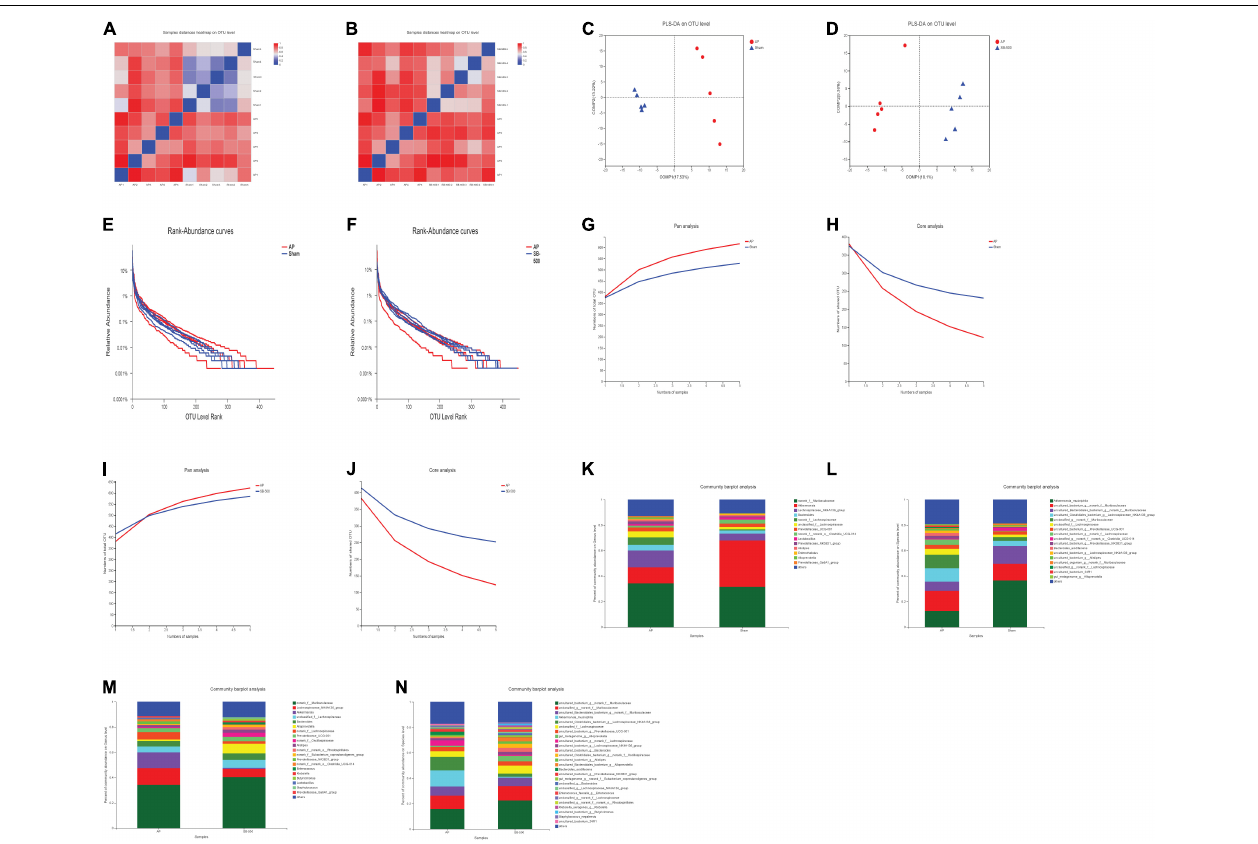
FIGURE 6 | (A,B) The heat map of the correlation of samples in the beta diversity analysis in the AP vs. Sham and SB-500 vs. AP groups. (A) AP vs. Sham group. (B) SB-500 vs. AP group. The distance between samples is represented by a certain color gradient, which is shown on the right. The size of the distance can be seen from the similar color areas. The closer to the red color, the smaller the difference between the two samples. Sham, Sham operation group; AP, acute pancreatitis group; SB-500, 500 mg/kg butyric acid intervention group. (C,D) Sample grouping analysis (PLS-DA) in the AP vs. Sham and SB-500 vs. AP groups. (C) AP vs. Sham group. (D) SB-500 vs. AP group. Sham, Sham operation group; AP, acute pancreatitis group; SB-500, 500 mg/kg butyric acid intervention group; PLS-DA, partial least squares discriminant analysis. (E,F) Rank-abundance analysis in the AP vs. Sham and SB-500 vs. AP groups. The X and Y axes represent the operational taxonomic unit (OTU) level rank and relative abundance, respectively. Sham, Sham operation group; AP, acute pancreatitis group; SB-500, 500 mg/kg butyric acid intervention group. (G–J) Pan/Core analysis in the (G,H) AP vs. Sham and (I,J) SB-500 vs. AP. The X and Y axes represent the number of observed samples and the number of OTU shared by all samples in a grouping category, respectively. Pan OTU and core OTU represent the union number of common OTU and the intersection number of common OTU, respectively. Sham, Sham operation group; AP, acute pancreatitis group; SB-500, 500 mg/kg butyric acid intervention group. (K–N) The community in the bar chart of the (K,L) AP vs. Sham and (M,N) SB-500 vs. AP groups. The left and right panels represent the genus and species levels, respectively. Sham, Sham operation group; AP, acute pancreatitis group; SB-500, 500 mg/kg butyric acid intervention